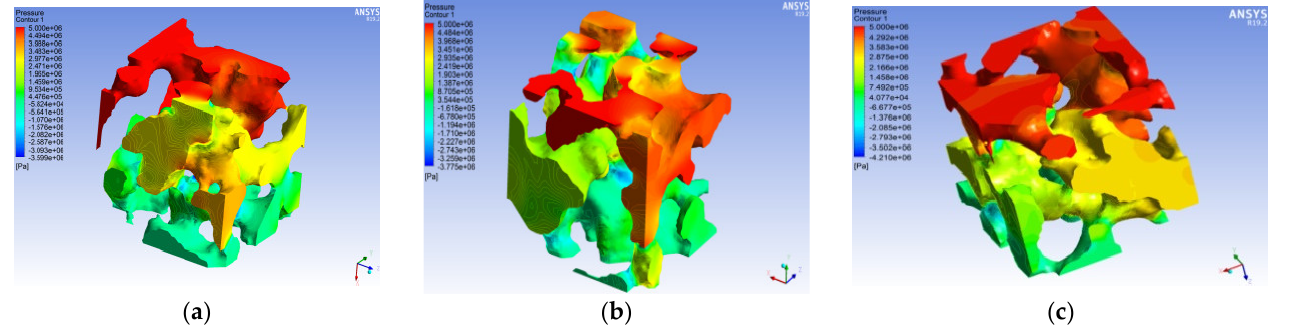
Figure 19. X, Y, and Z negative single channel seepage water pressure distribution diagram. ( a ) X negative direction, ( b ) Y negative direction, and ( c ) Z negative direction.